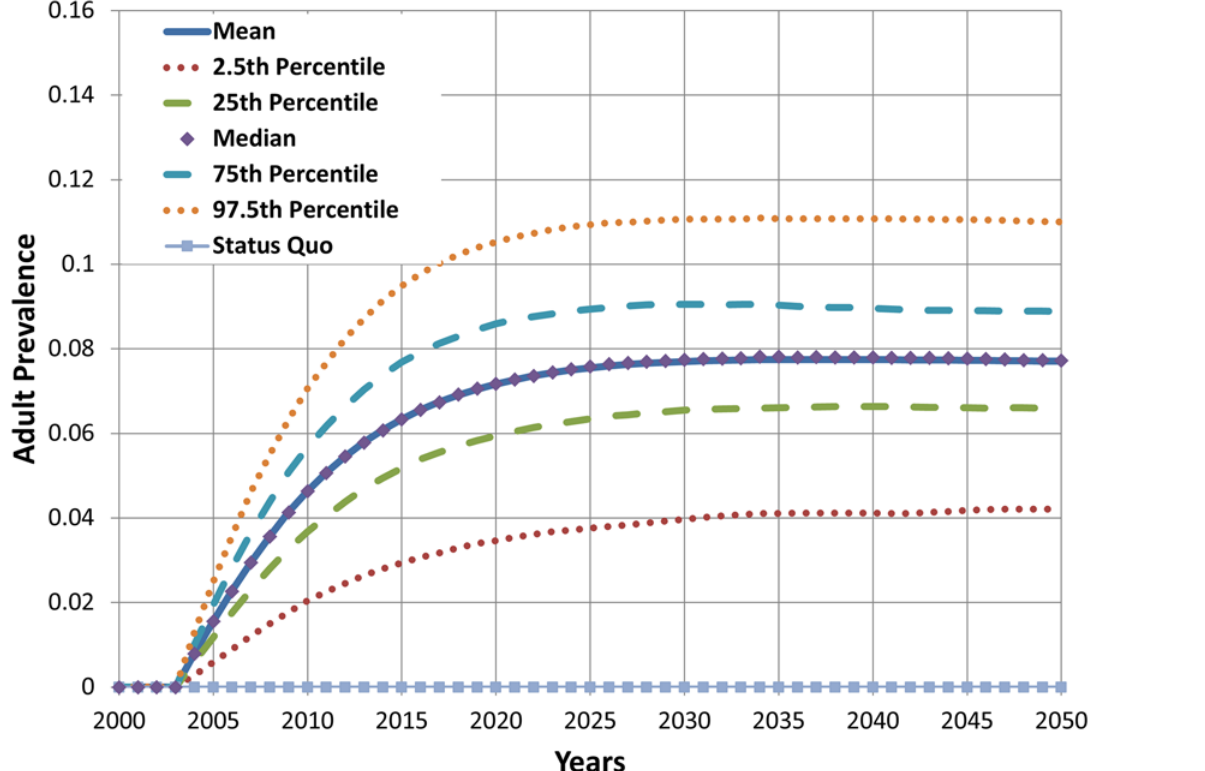
Fig 13. Projected adult prevalence of new product use from multivariate uncertainty analysis, 2000 –